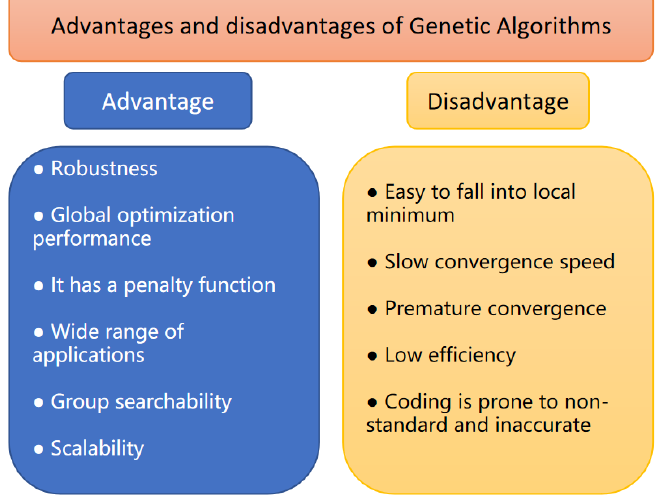
Figure 4. Comparison of advantages and disadvantages of genetic algorithm.